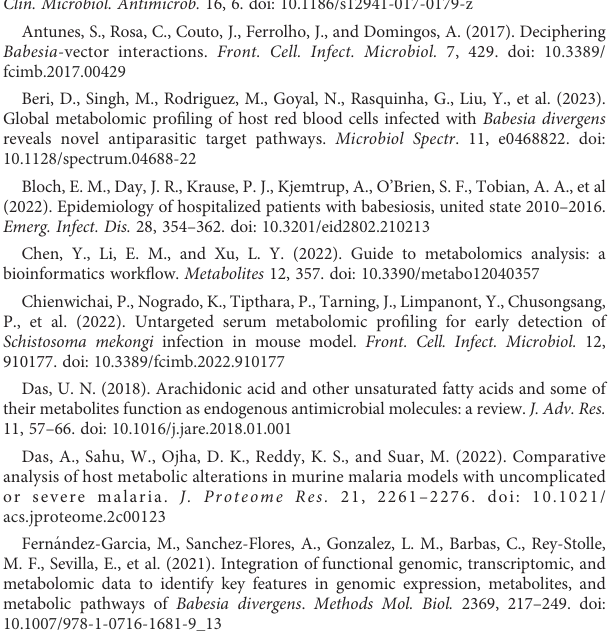
SUPPLEMENTARY FIGURE 1 Orthogonal partial least squares discriminant analysis (OPLS-DA) of the metabolite pro fi le. (A) and (C): OPLS-DA score plots between the early infected group (EI) and the noninfected group (Ctrl) in ESI − mode (A) and ESI+ mode (C). (B) and (D): OPLS-DA model with 200 permutation tests between EI and Ctrl in ESI − mode (B) and in ESI+ mode (D). SUPPLEMENTARY FIGURE 2 Orthogonal partial least squares discriminant analysis (OPLS-DA) of the metabolite pro fi le. (A) and (C): OPLS-DA score plots between the early infected group (EI) and the acutely infected group (AI) in ESI − mode (A) and ESI+ mode (C). (B) and (D): OPLS-DA model with 200 permutation tests between EI and AI in ESI − mode (B) and in ESI+ mode